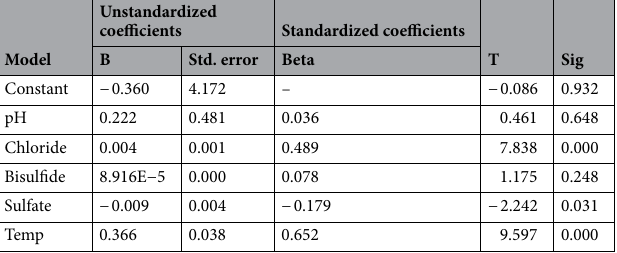
Table 5. Coefficients of linear regression model for predicting i corr of carbon steel in soil.